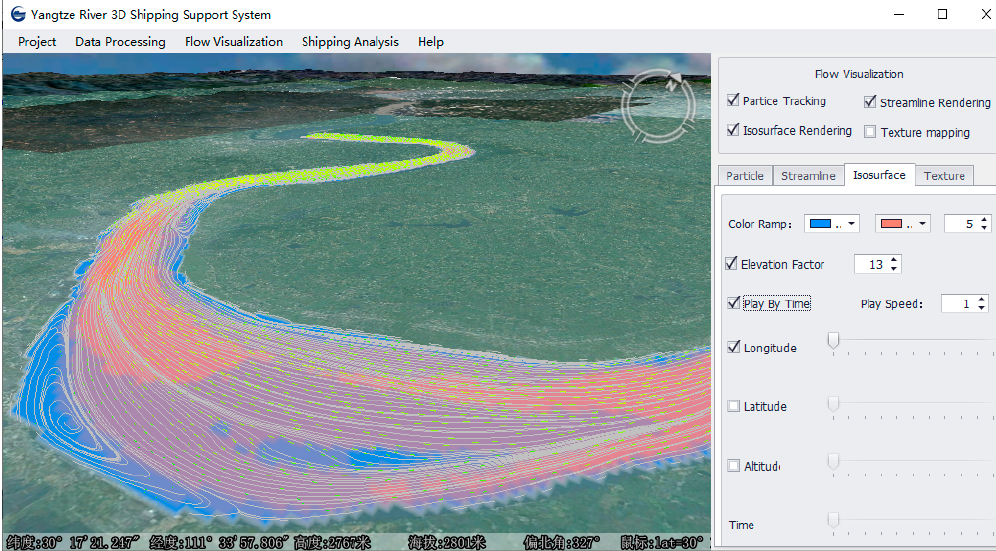
Figure 13. Interactive hybrid flow visualization (combining particle tracking, streamline rendering, and contour surface rendering).